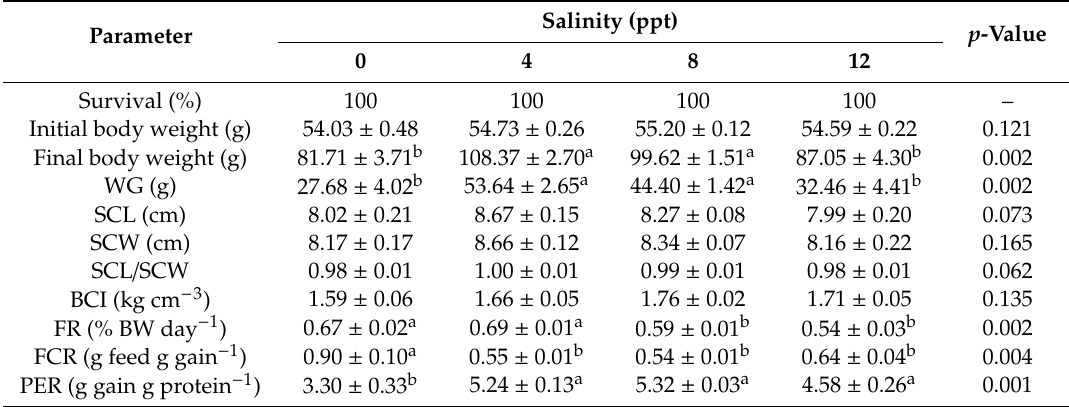
Table 1. Survival, growth performance, and feed utilization of northern river terrapins reared in various salinities. The observed parameters were recorded at the end of the 8-week